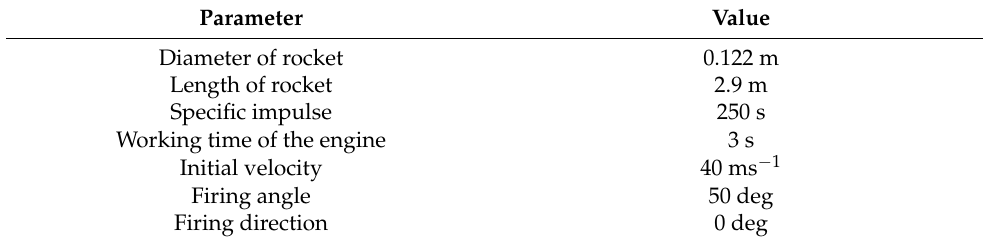
Table 5. Basic parameters of the rocket projectile.